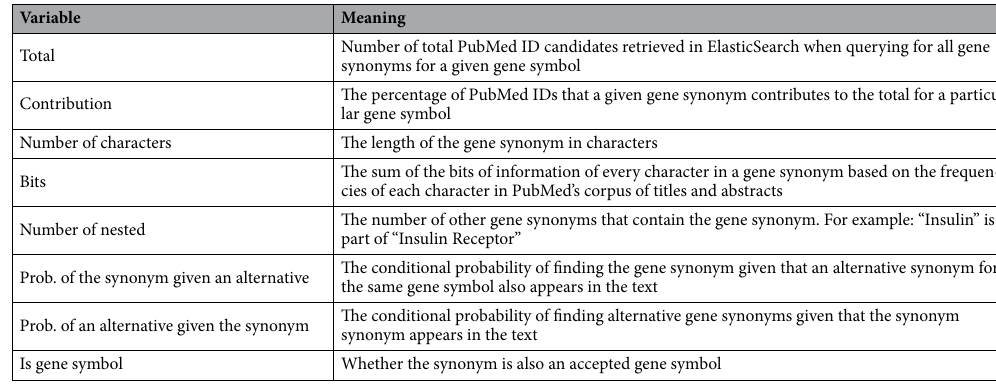
Table 2. Unsafe features. Engineered features to evaluate the probability of a given gene symbol of being ambiguous (unsafe).